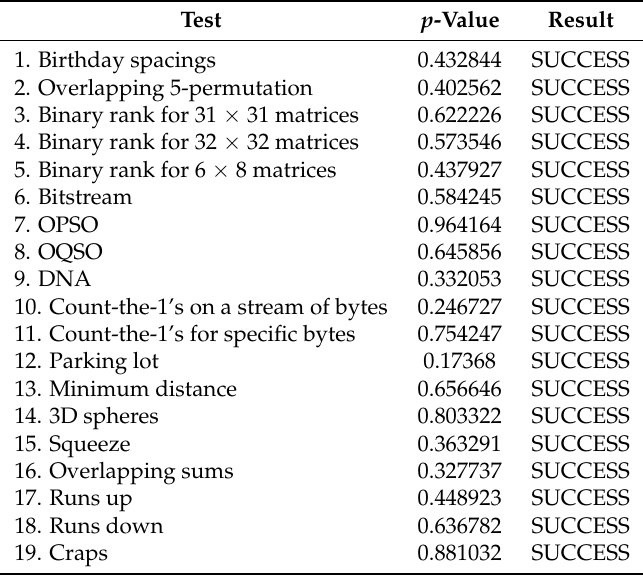
Table 5. p -values returned by DIEHARD tests when evaluating a sequence of 1.024 × 10 9 bits generated by GBPA.